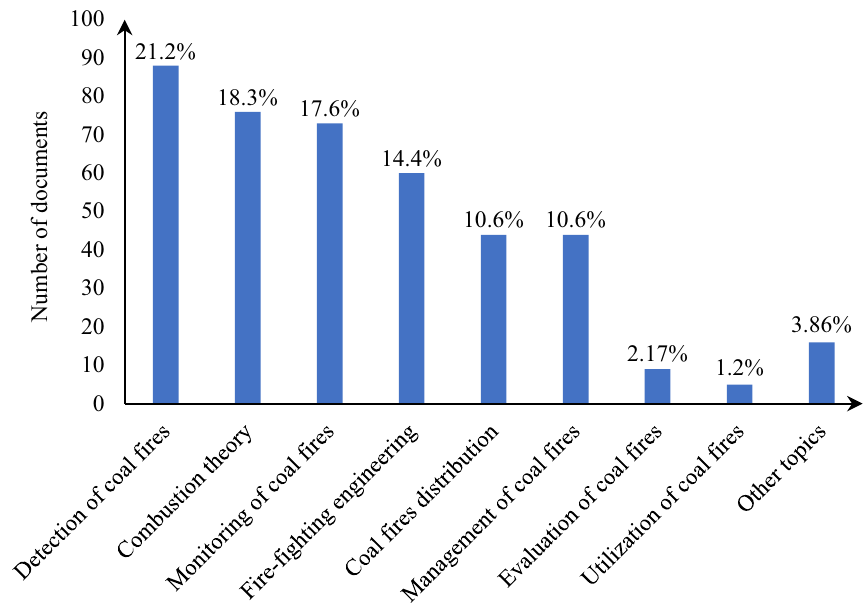
Fig. 4 Main research topics